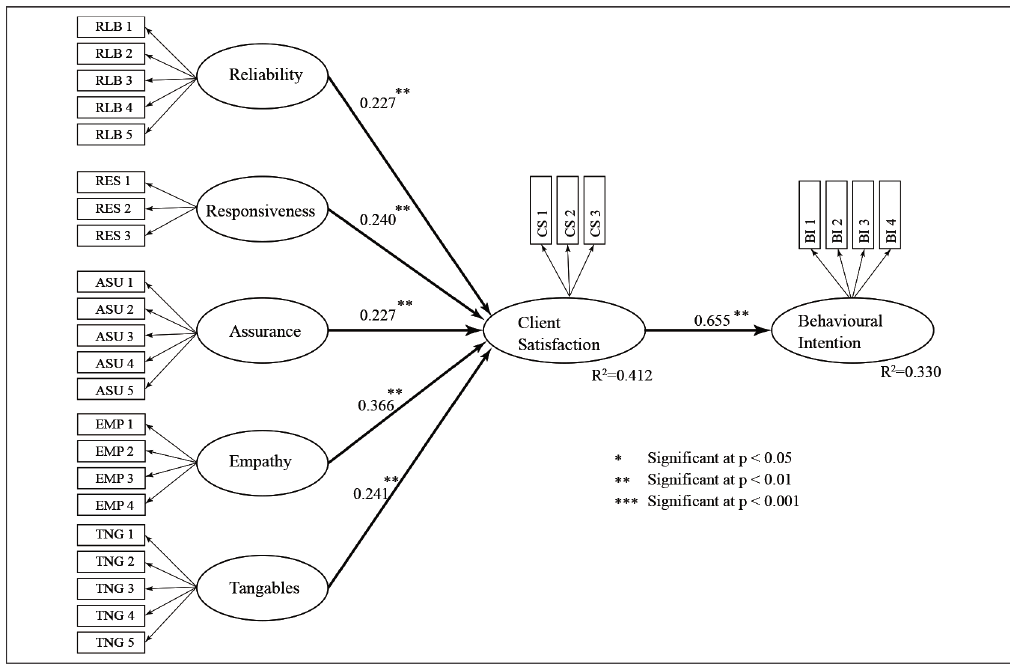
Figure 2. The structural equation model